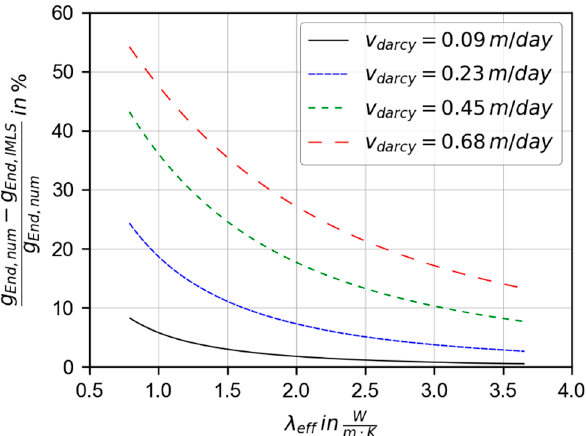
Figure 4. Deviation of the g-functions between the numerical model with a grouted borehole and the analytical infinite MLS model.